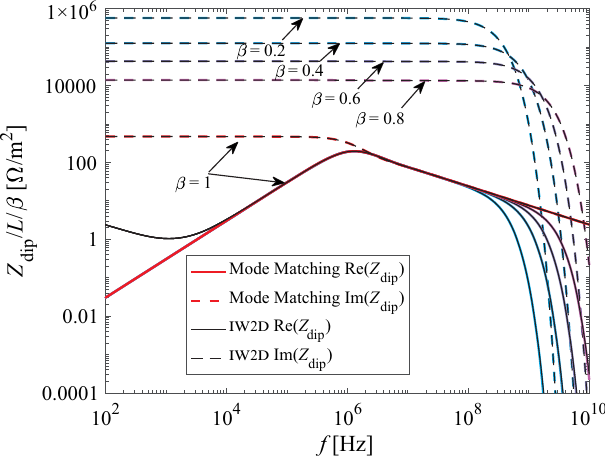
FIG. 11. Comparison between the mode matching and IW 2 D code for different relativistic β . The thick line is the real part and the dashed line is the imaginary part of the impedance. The transverse impedance is normalized over β . Mode matching parameters: b ¼ 0 . 05 m, t ¼ 0 . 5 mm, L ¼ 20 cm, σ ¼ 10 6 S = m,